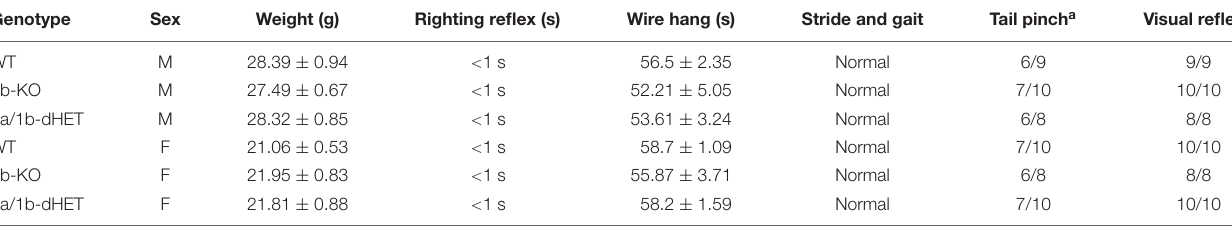
TABLE 1 | Analysis of basic motor and sensory function in 1b-KO and 1a/1b-dHET mice. Genotype